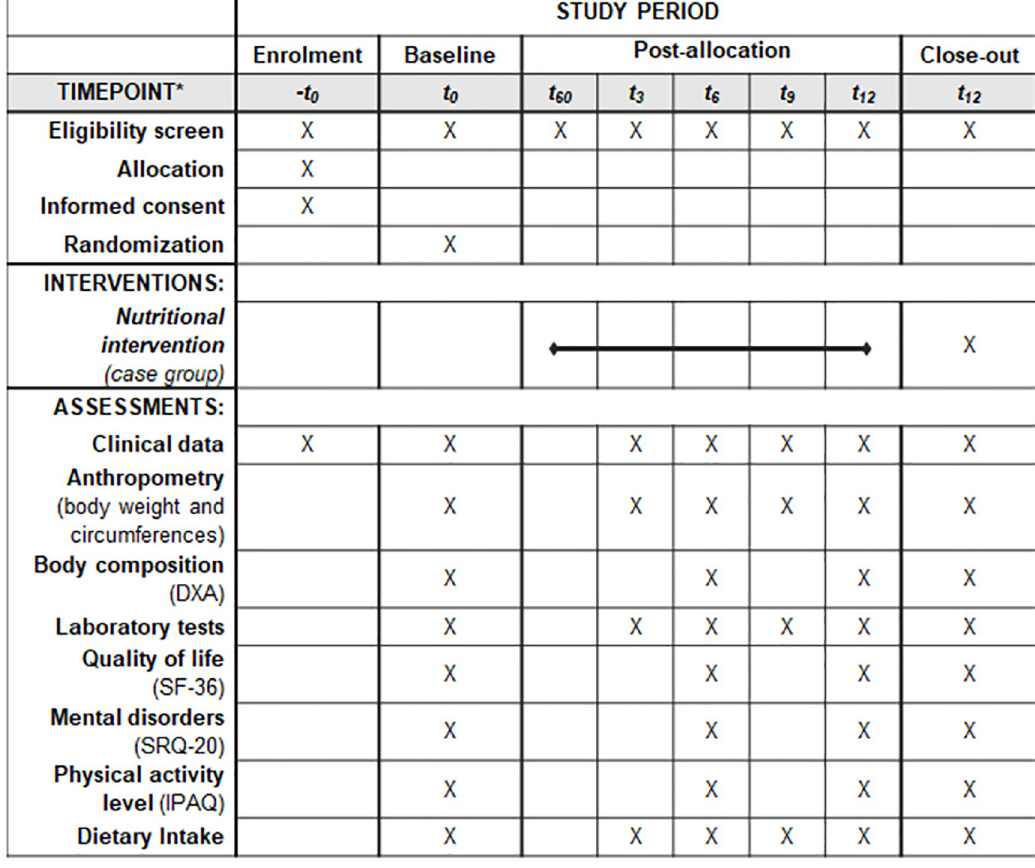
Fig 2. SPIRIT diagram. � Time-points of the protocol: -T0, enrolment; T0, baseline; T60, 60th day after transplant; T3, month 3; T6, month 6; T9, month 9; T12, month 12. DXA, double-beam X-ray absorptiometry ; SF-36, Medical Outcomes Study 36-Item Short- Form Health Survey ; SRQ-20, Self-Reporting Questionnaire ; IPAQ, International Physical Activity Questionnaire .